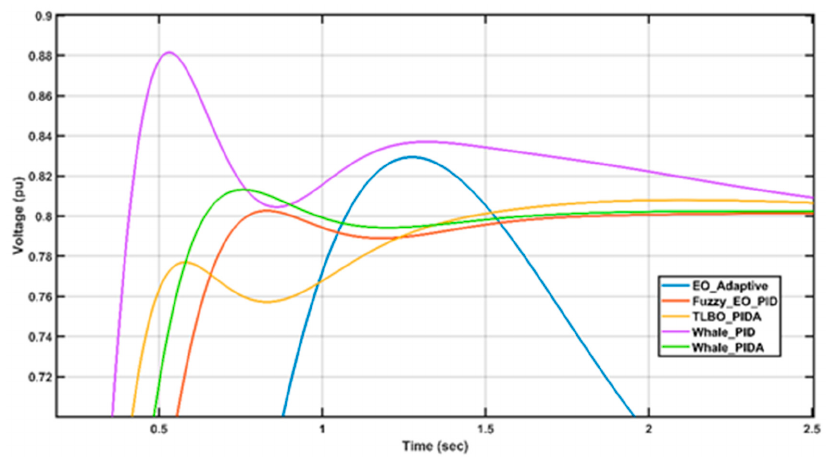
Figure 10. 0.8 pu step voltage reference for simple AVR model.